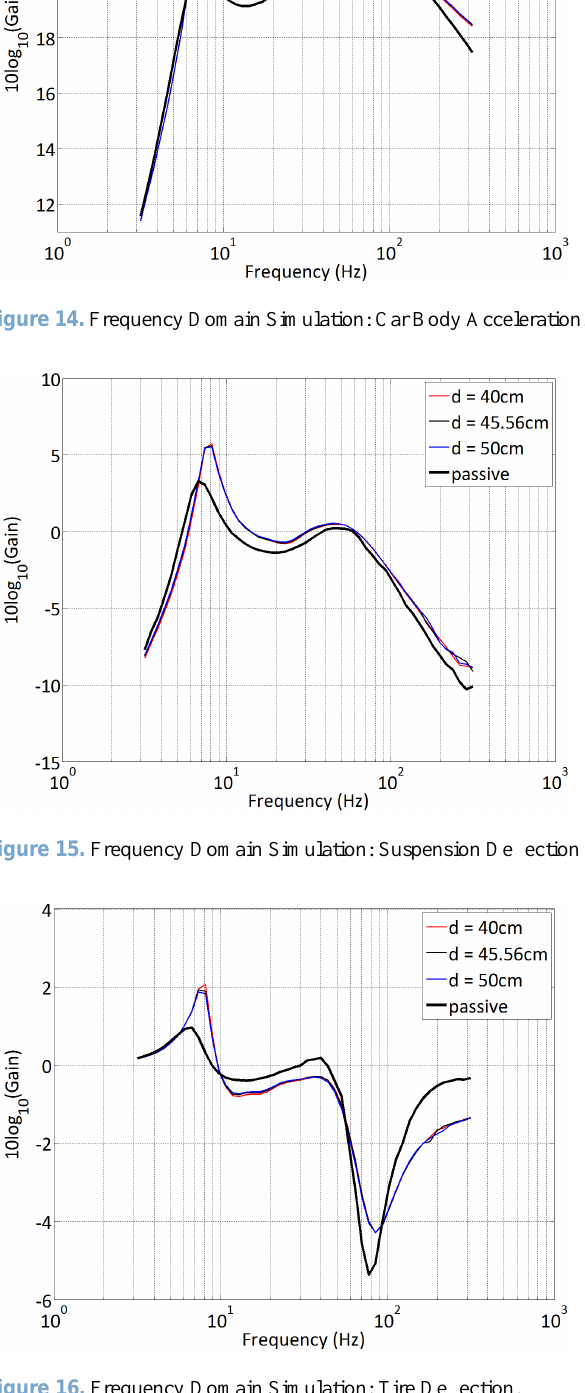
Figure 16. Frequency Domain Simulation: Tire